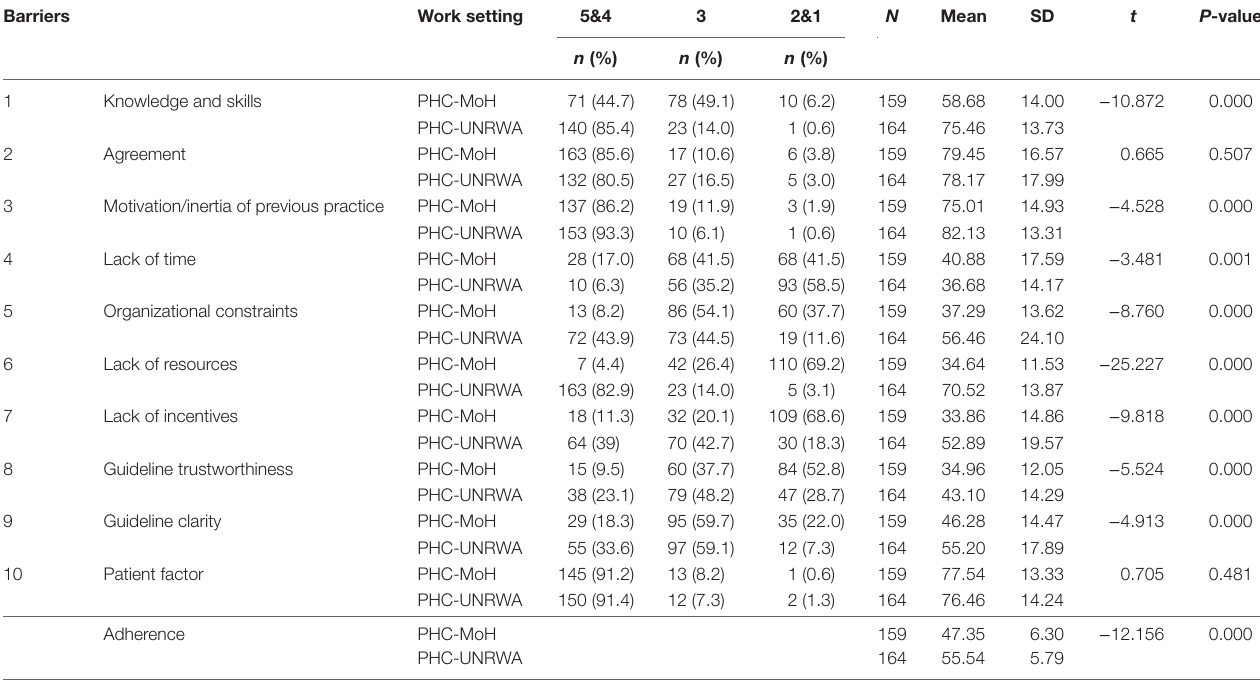
TaBle 4 | Perceived Barriers of adherence to the diabetic